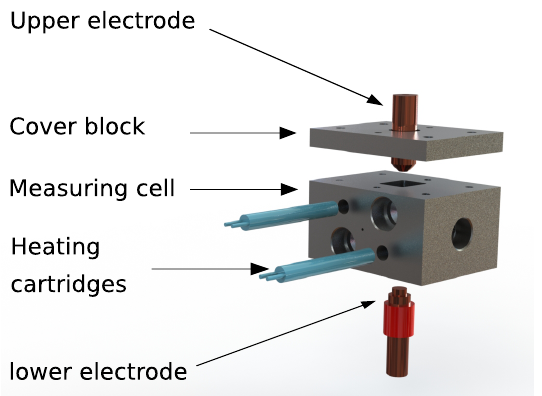
Figure 4. Concept of the measurement cell with heating cartridges and copper electrodes to contact the sample inside of an aluminium